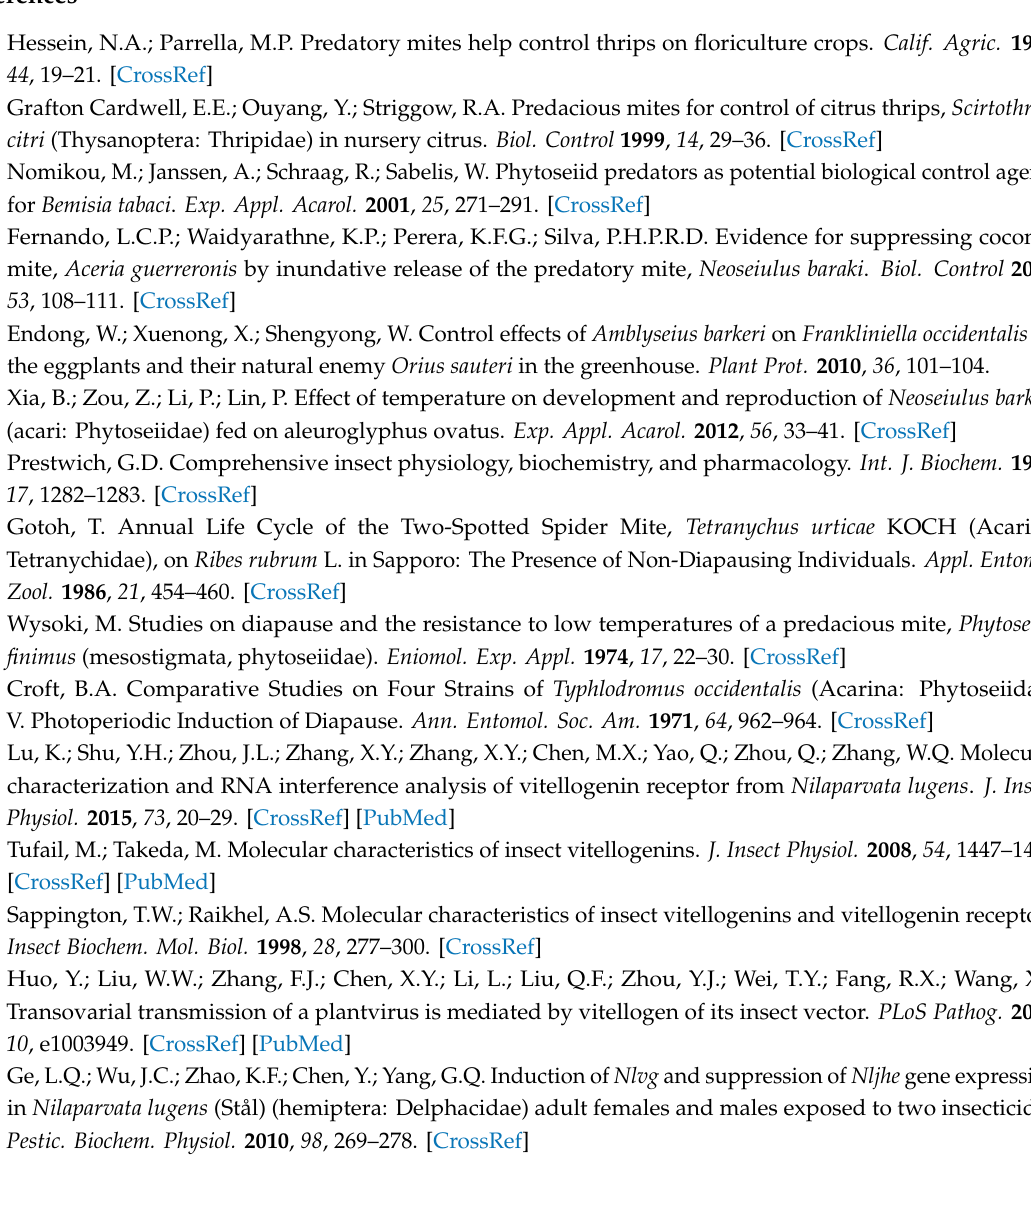
Figure S1: Collection device of Neoseiulus barkeri ; Table S1: BLAST alignment of the Vg1 gene of Neoseiulus barkeri with other species in the NCBI database; Table S2: BLAST alignment of the Vg2 gene of Neoseiulus barkeri with other species in the NCBI database; Table S3: BLAST alignment of the Vg3 gene of Neoseiulus barkeri with other species in the NCBI database; Table S4: BLAST alignment of the VgR gene of Neoseiulus barkeri with other species in the NCBI